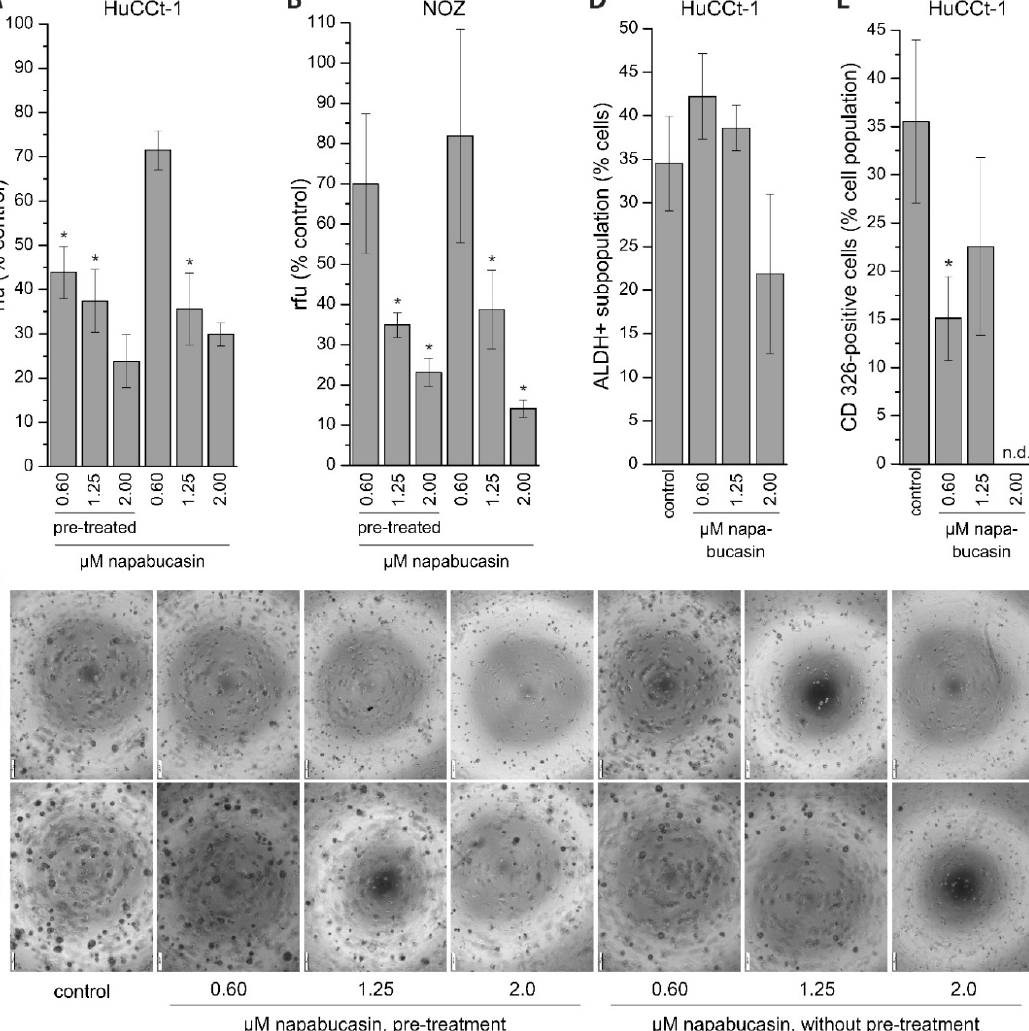
Figure 3. Effect of napabucasin on functional cancer stem cell characteristics. ( A , B ): Results of soft